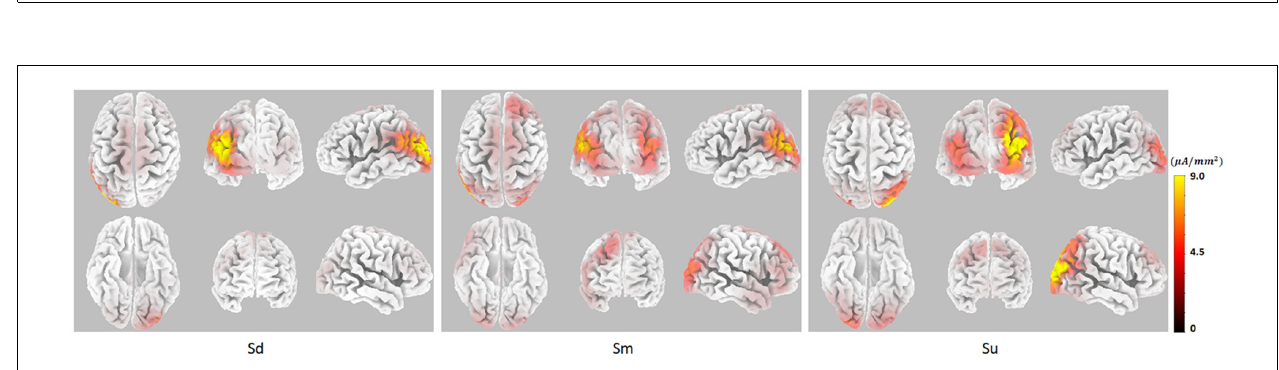
FIGURE 5 | The averaged event-related potential (ERP) waveforms of all EEG channels for Sd, Sm and Su intentions for all participants. All channels have a negative amplitude at the 0 point because they were affected by the visual evoked potential induced by the − 500 ms cue stimulus. Channel marked with two asterisks indicates a statistically significant difference in the amplitude ( P <